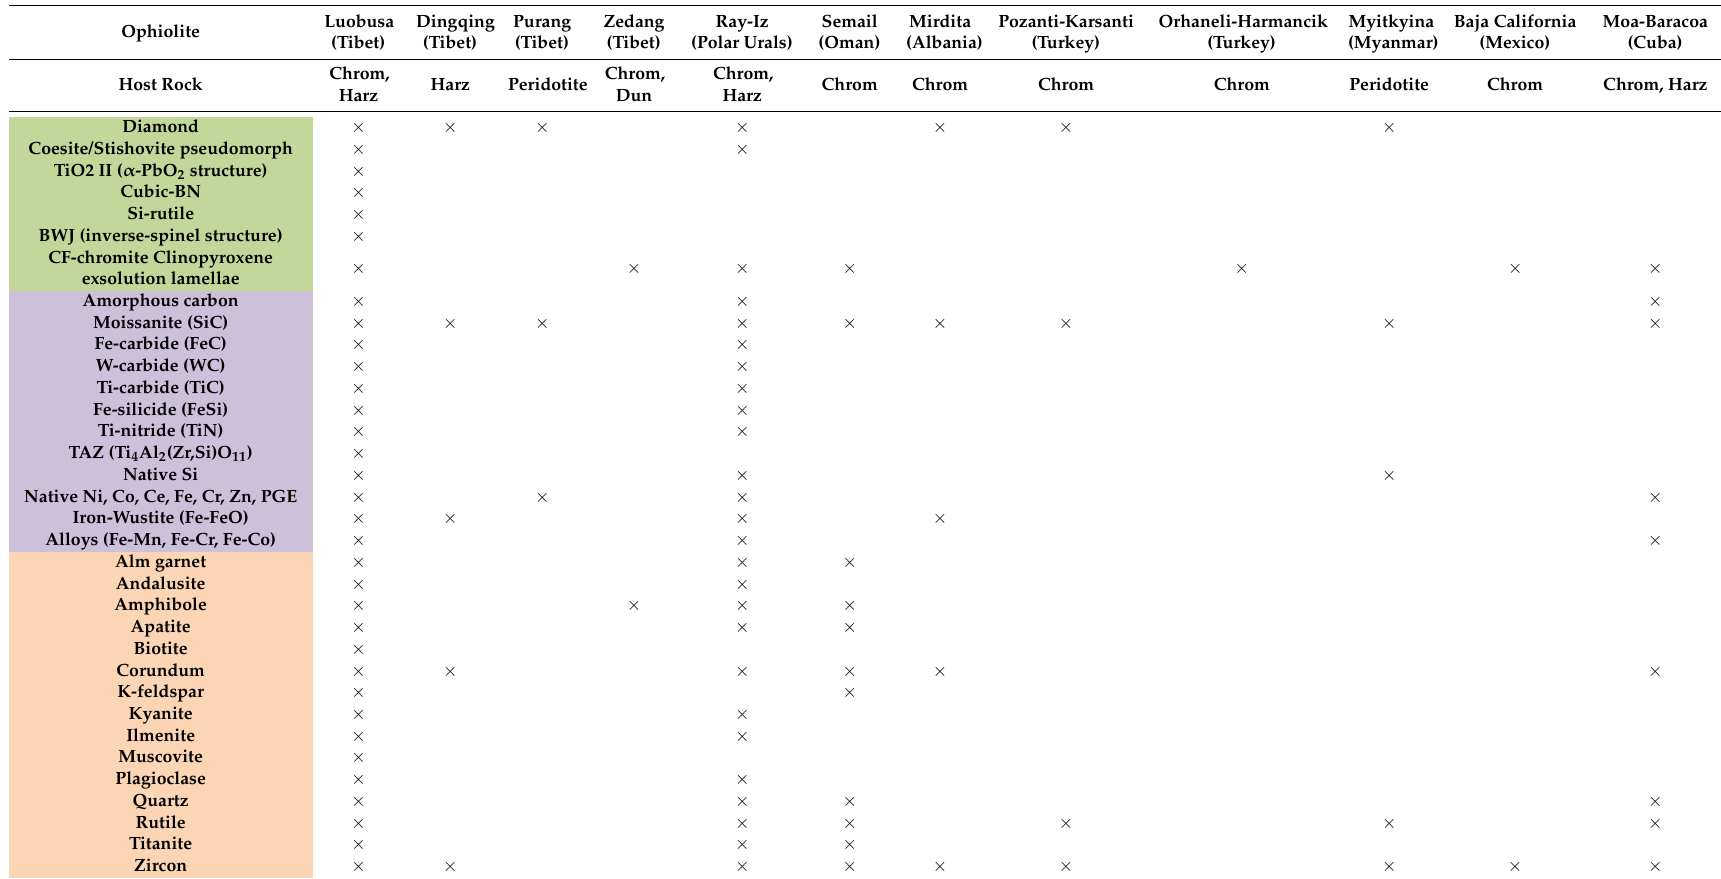
× : Indicates the presence of the mineral in the ophiolite (peridotites and/or